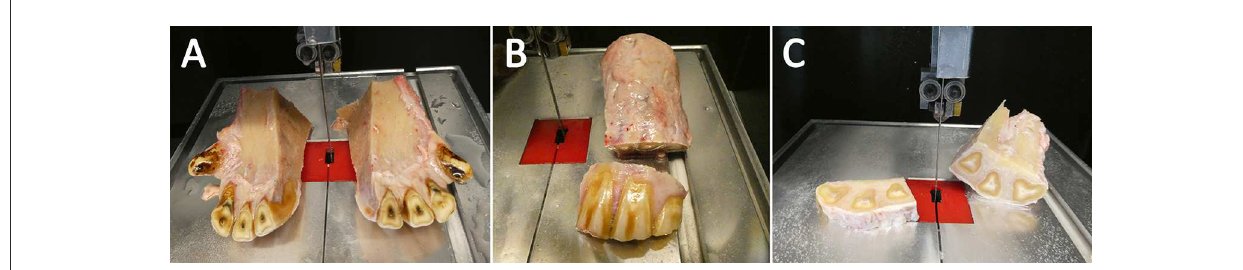
FIGURE2 Tissue preparation. The samples were sliced through the sagittal plane (A) . Afterwards the clinical crone was segmented and rejected (B) Finally, horizontal sections were sliced (C) .